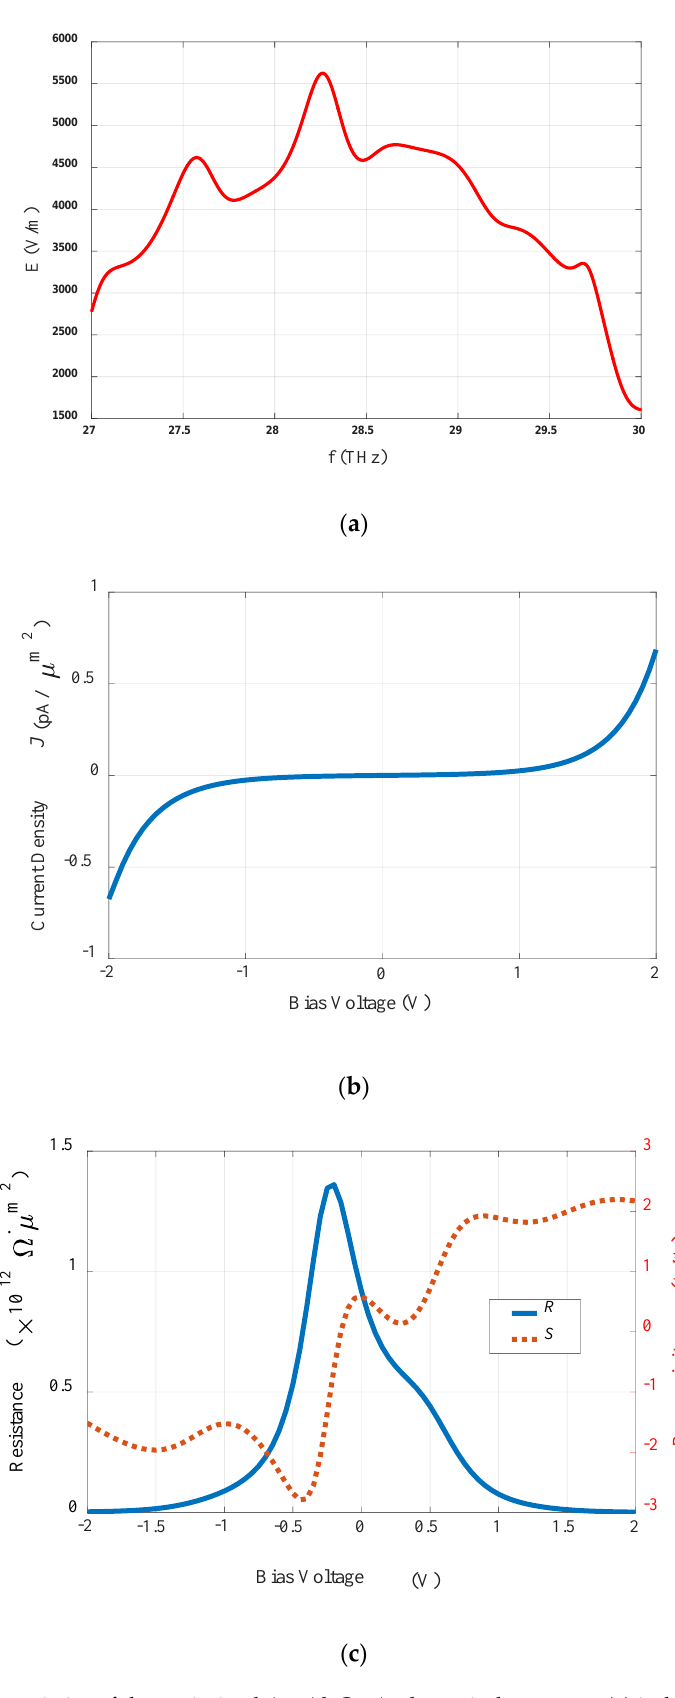
Figure 4. Characteristics of the optimized Au-Al 2 O 3 -Au log spiral rectenna: ( a ) induced electric field; ( b ) current-voltage; and ( c ) resistance and responsivity.